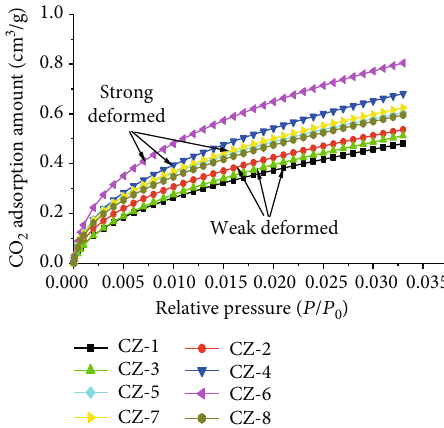
Figure 3: CO adsorption isotherms of the Lujiaping 2